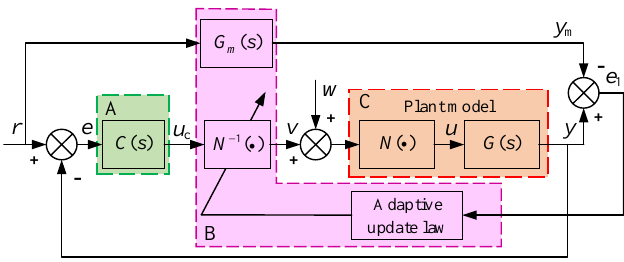
( b ) Figure 4. The fitting results: ( a ) Control input signal and fitting curves of the subsystem 1 G ; ( b ) Control input signal and fitting curves of the subsystem 2 G . 3. Model Reference Adaptive Dead-Zone Inverse Controller 3.1. Design of Controller In this section, a model reference adaptive dead-zone inverse controller (MRADIC) is designed for each channel. In Figure 5, the control structure consists of three parts: (A) a position controller, (B) a model reference adaptive dead-zone inverse controller, and (C) a plant model. In Figure 5, the r is the expected trajectory signal from trajectory generator;